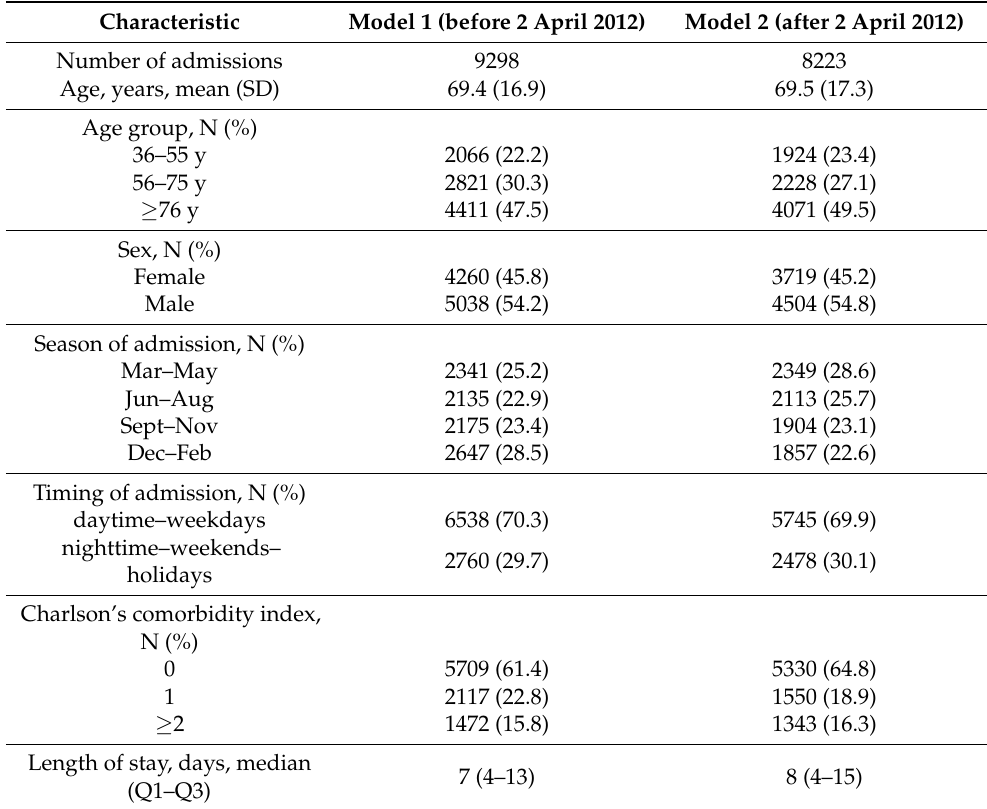
Table 1. Characteristics of the patient populations assisted under organizational Models 1 and 2 *.